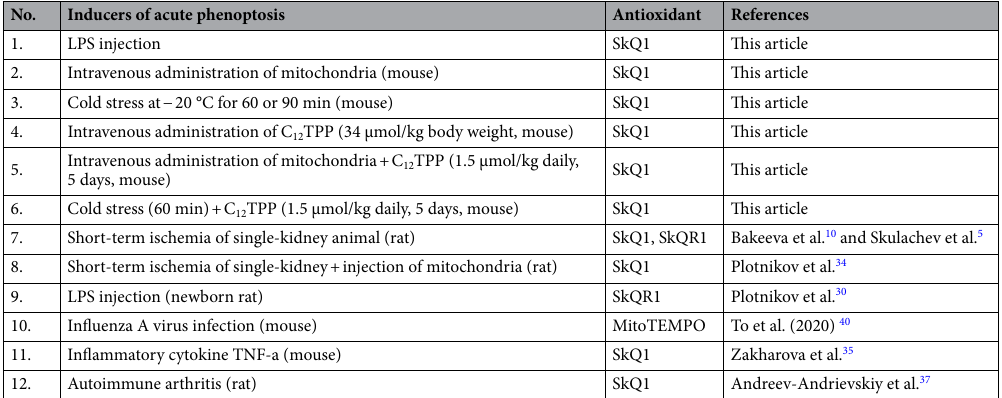
No. Inducers of acute phenoptosis